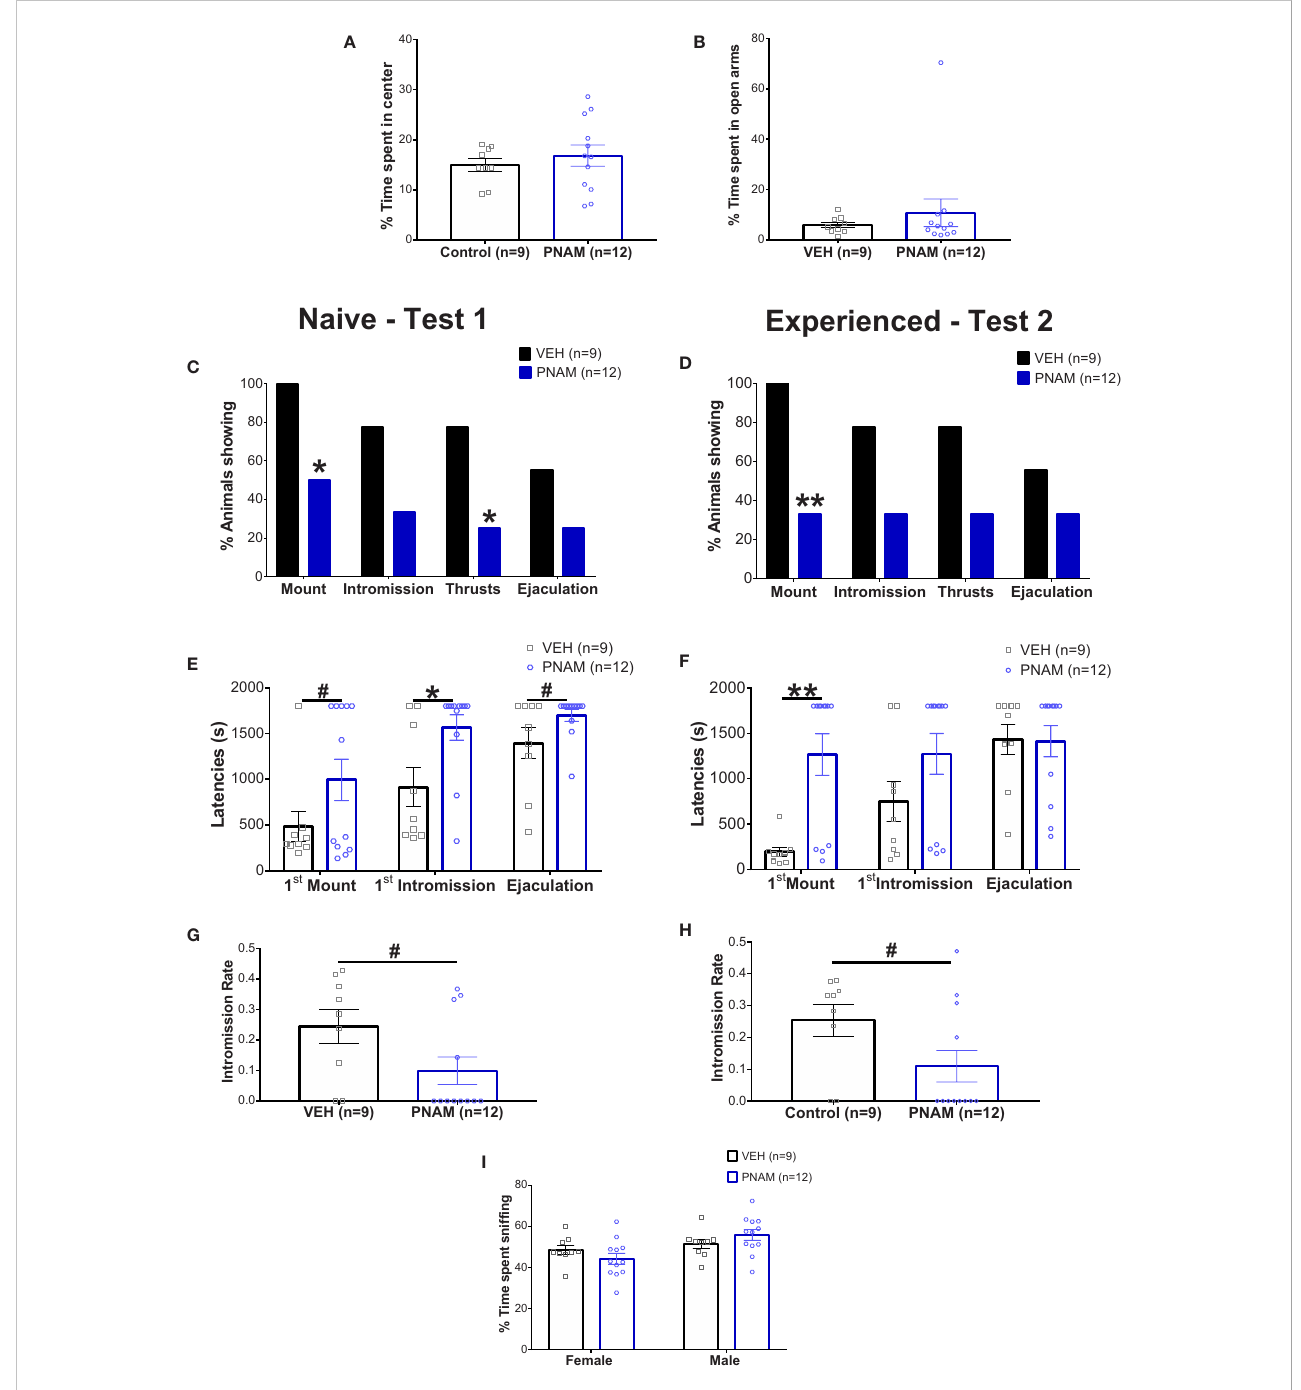
FIGURE 2 Prenatal DHT exposure modi fi es male-typical sexual behavior. (A, B) Histogram representing the percentage of time spent in the center zone of the Open- fi eld test (A) and the percentage of time spent in the open arms of the Elevated-plus maze (B) for the VEH male (black bar) and PNAM (dark blue bar). (C, D) Histograms representing the percentage of animals performing each component of male copulatory behavior (mount, intromission, pelvic thrusts and ejaculation) while naive (C) (i.e. during the fi rst test) or experienced (D) (i.e. during the second test) for the VEH male (black bars) and PNAM (dark blue bars). (E, F) Histograms representing the latencies to fi rst mount, fi rst intromission and ejaculation while naive (E) (i.e. during the fi rst test) or experienced (F) (i.e. during the second test) for the VEH male (black bars) and PNAM (dark blue bars). (G, H) Histograms representing the intromission rate, corresponding to the number of mounts with intromission divided by the total number of mount trial, while naive (C) (i.e. during the fi rst test) or experienced (D) (i.e. during the second test) for the VEH male (black bar) and PNAM (dark blue bar). (I) Histograms representing the percentage of time spent snif fi ng either the male of the female compartment in the three-compartment box partner preference test for the VEH male (black bars) and PNAM (dark blue bars). **p<0.01, *p<0.05, # p<0.07. VEH, control male; PNAM, prenatally androgenized male, s, seconds. Mean +/-